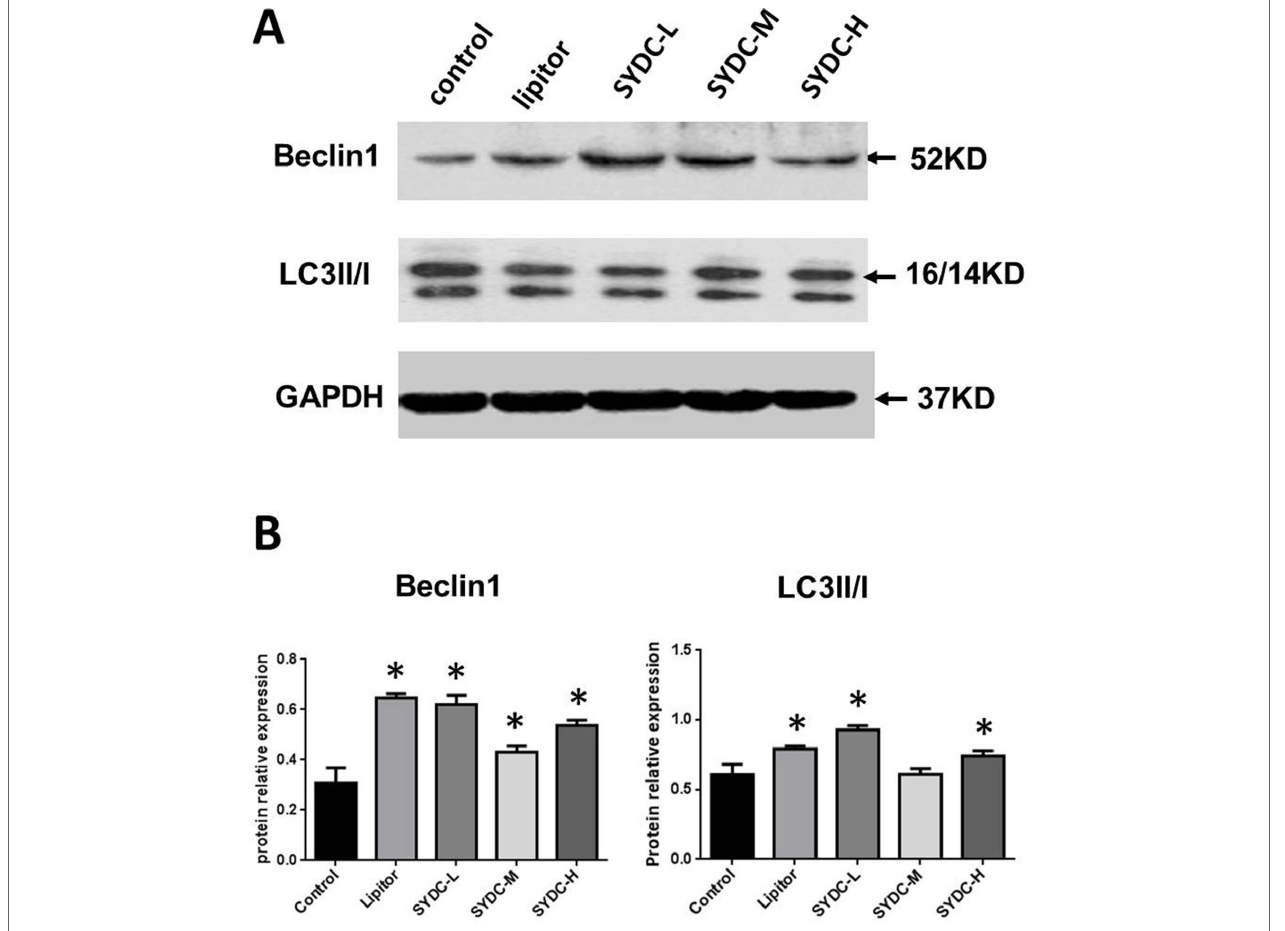
FIGURE 2 | Effect of SYDC on autophagy. (A) Representative images of Western blot showing Beclin-1 expression and the LC3II/I ratio in aortic samples. GAPDH was used as a loading control. (B) Densitometry values of the western blot analysis were normalized to GAPDH expression and represented as relative intensity. * P < 0.01 vs. control group, SYDC-H, high-SYDC (160 mg/kg), SYDC-M, middle-SYDC (80 mg/kg), and SYDC-L, low-SYDC (40 mg/kg) (n =